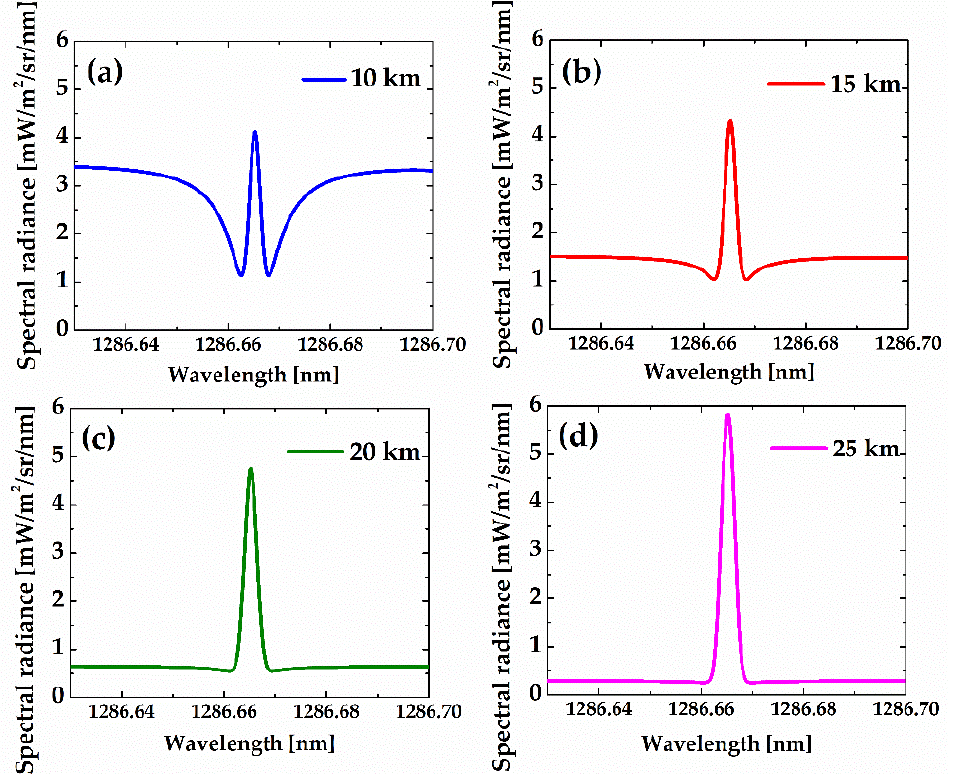
Figure 14. The total spectral brightness of the R 9 Q 10 line varying with tangent heights.